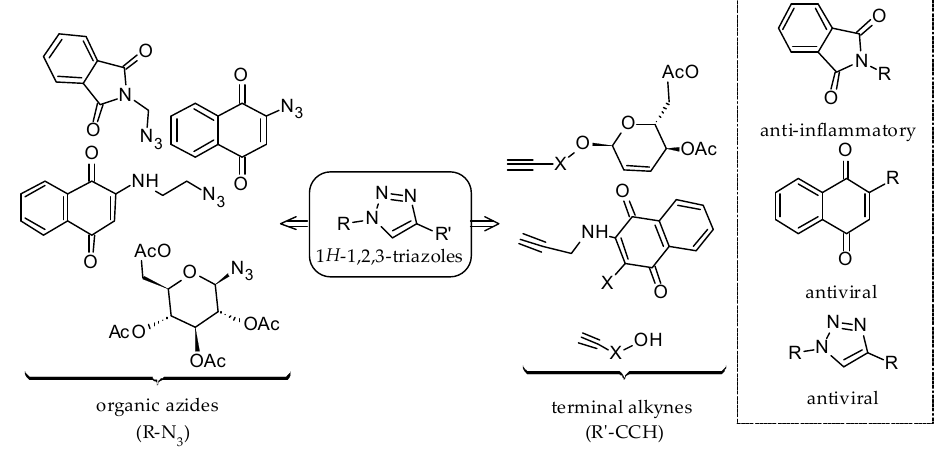
Figure 1. Strategy for molecular diversity towards antiviral 1 H